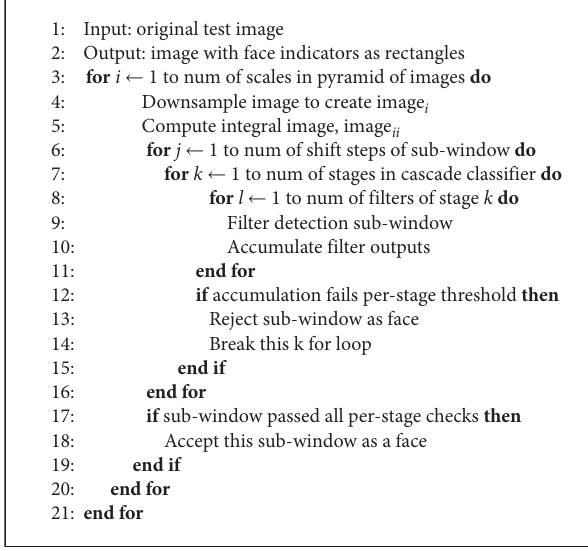
Figure 2: Viola–Jones detection algorithm.